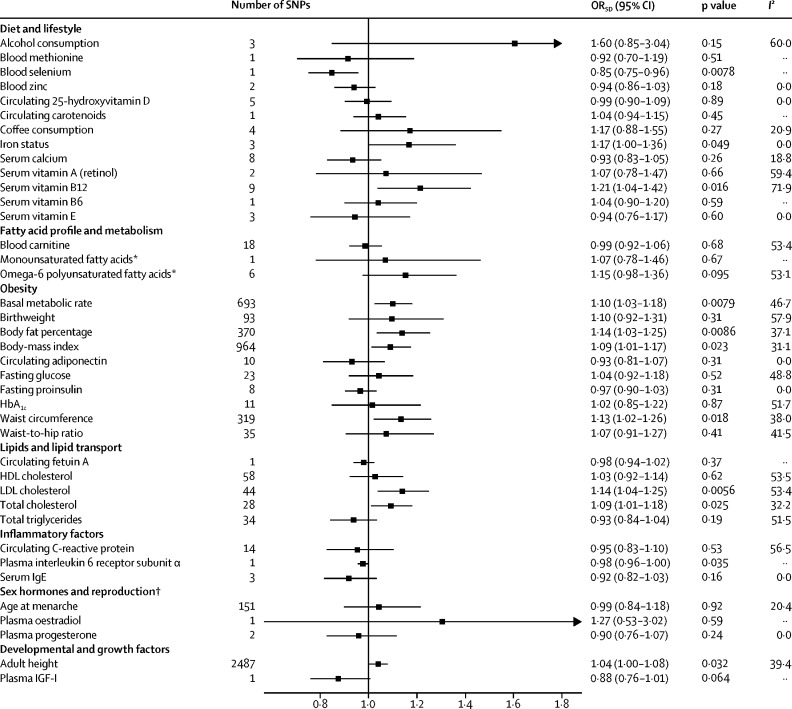
ORSD for associations between genetically predicted risk factors and colorectal cancerWe used a maximum likelihood estimate random-effects method to summarise Wald ratio estimates from individual SNPs. ORSD=odds ratio per genetically predicted SD unit increase in the risk factor. SNP=single-nucleotide polymorphism. *Restricted analyses that excluded SNPs associated with other classes of fatty acid. †ORSD estimated based on colorectal cancer summary statistics for women only.